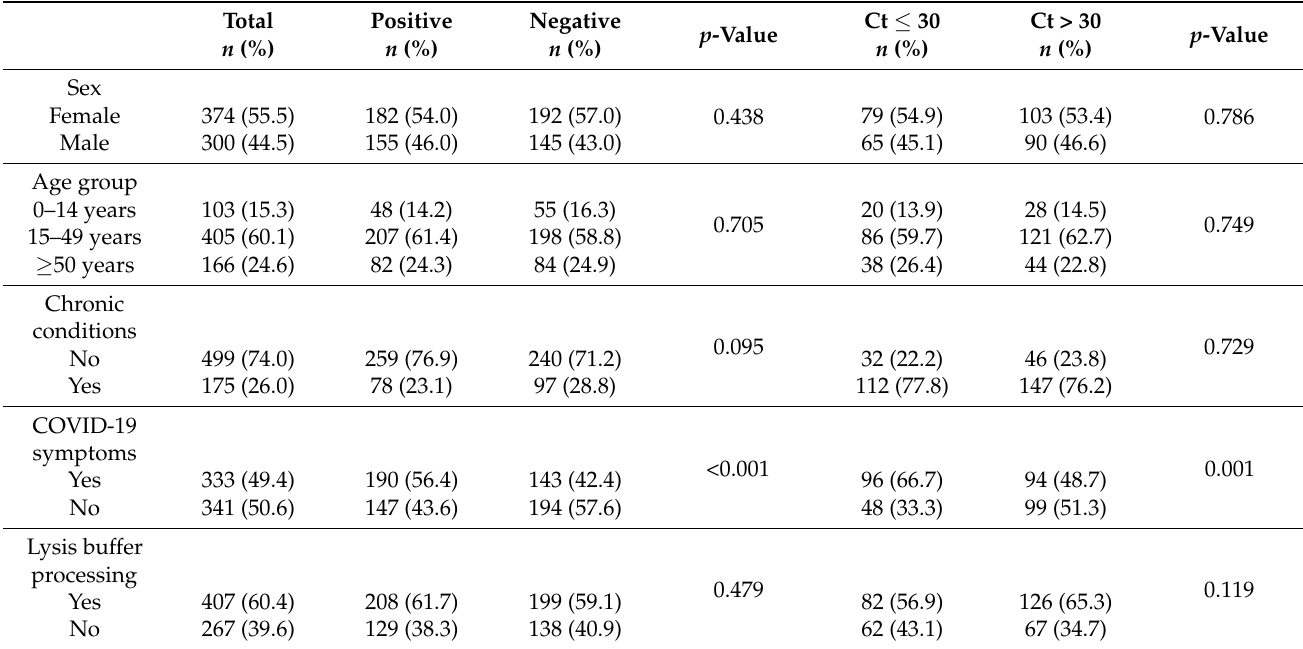
Table 1. Main characteristics of the patients according to the RT-qPCR result from nasopharyngeal samples.